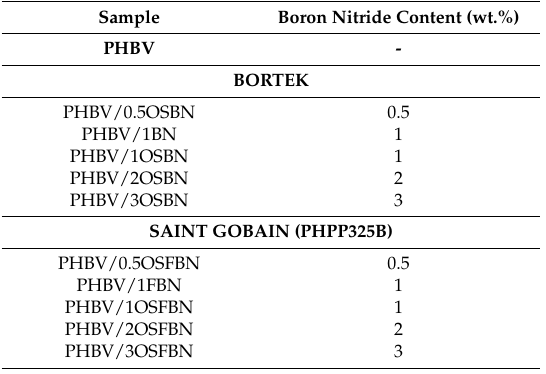
Table 1. The prepared nanobiocomposites for mechanical